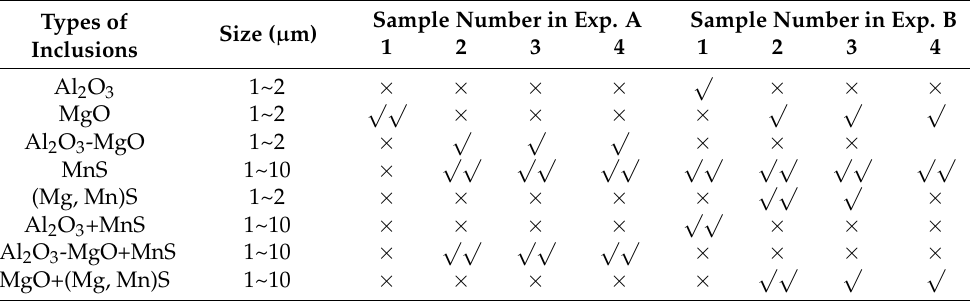
Figure 5. Typical oxysulfide inclusions in steels: ( a ) Al 2 O 3 +MnS; ( b ) MgO-Al 2 O 3 +MnS; ( c ) MgO+(Mg, Mn)S. Table 4. Types of inclusions in different